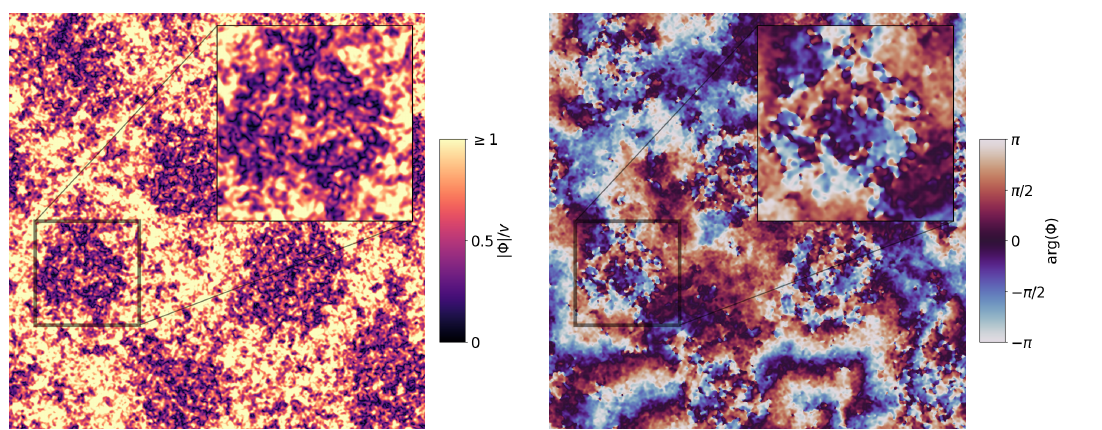
Figure 5 . Snapshot at late times of the complex scalar Φ from the same case with λ/g 2 shown in figure 4. The left panel shows the magnitude of Φ , while the right panel shows the complex phase. In both panels, the inset at the top right shows a zoom-in of a region where a number of vortices have formed. The length of the domain is twice the wavelength of the dominant mode of the axion instability, the latter of which is approximately equal to the Compton wavelength of the dark photon ( L = 4 π/k p where k p ≈ 1 . 055 m A 0 ). A translational symmetry is assumed in the out-of-page